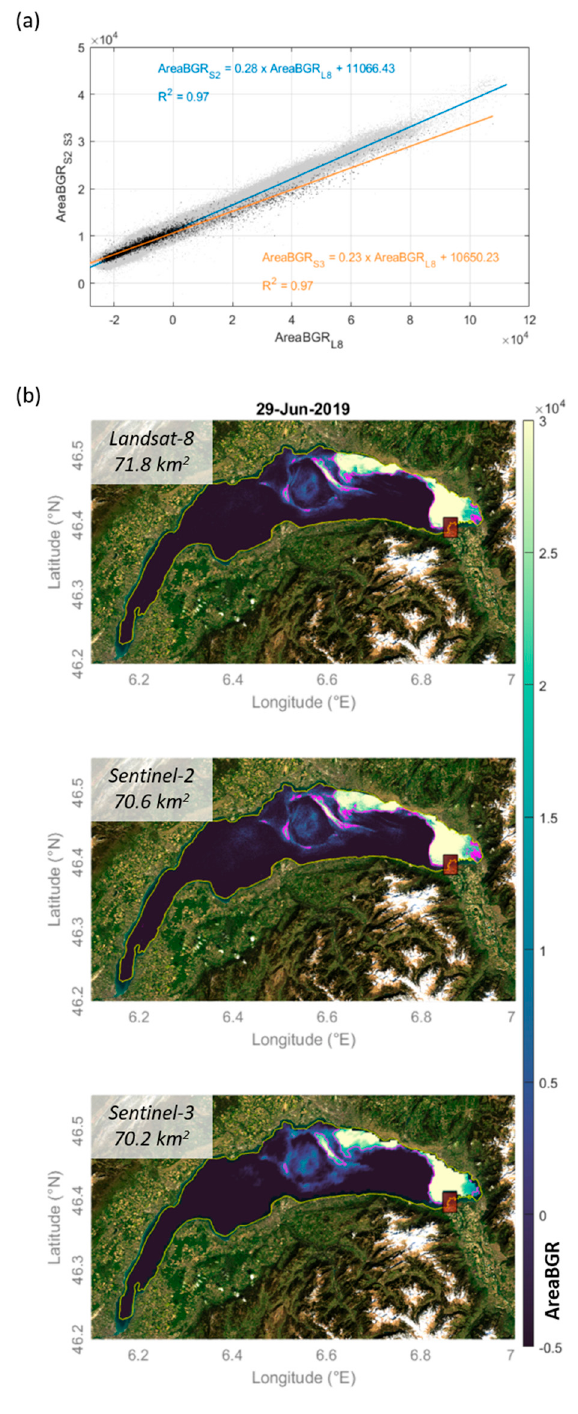
Figure 2. ( a ) Inter-calibration of the AreaBGR index of Landsat-8, Sentinel-2 and Sentinel-3 images on 29 June 2019. Regression between Landsat-8 and Sentinel-2 AreaBGR estimates (grey points) is shown in blue. Regression between Landsat-8 and Sentinel-3 AreaBGR estimates (black points) is shown in orange. The linear equations and correlation coefficients are specified. ( b ) Results of the inter-calibration of AreaBGR of Lake Geneva on 29 June 2019 for Landsat-8, Sentinel-2, and Sentinel-3 satellites. The whiting area is specified on each image. The delimitation of whiting areas based on the threshold of AreaBGR = 13000 is shown in magenta. The 20 m isobath used to discard shallow depth is shown in yellow. The Rhone estuary area is shown in red and is discarded from the calculation.